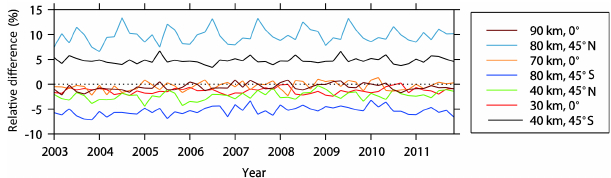
Fig. 8. Percentage of temperature relative difference at different al- titude and